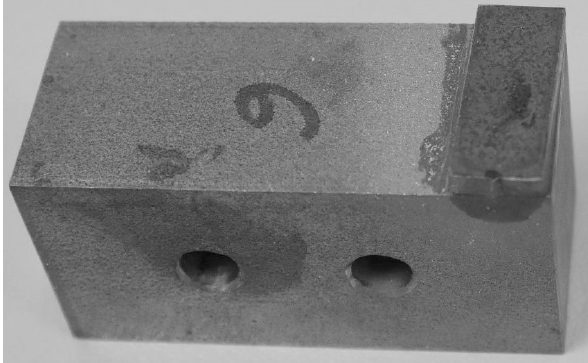
Figure 2. The block specimen. The top element is turned at an angle of about 1.5°.